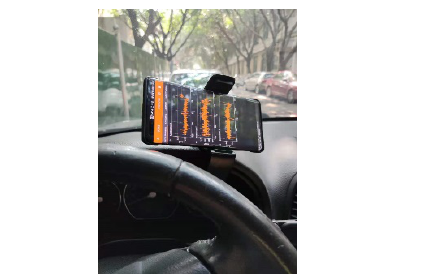
Figure 6. Smartphone mounting in tunnel experiment